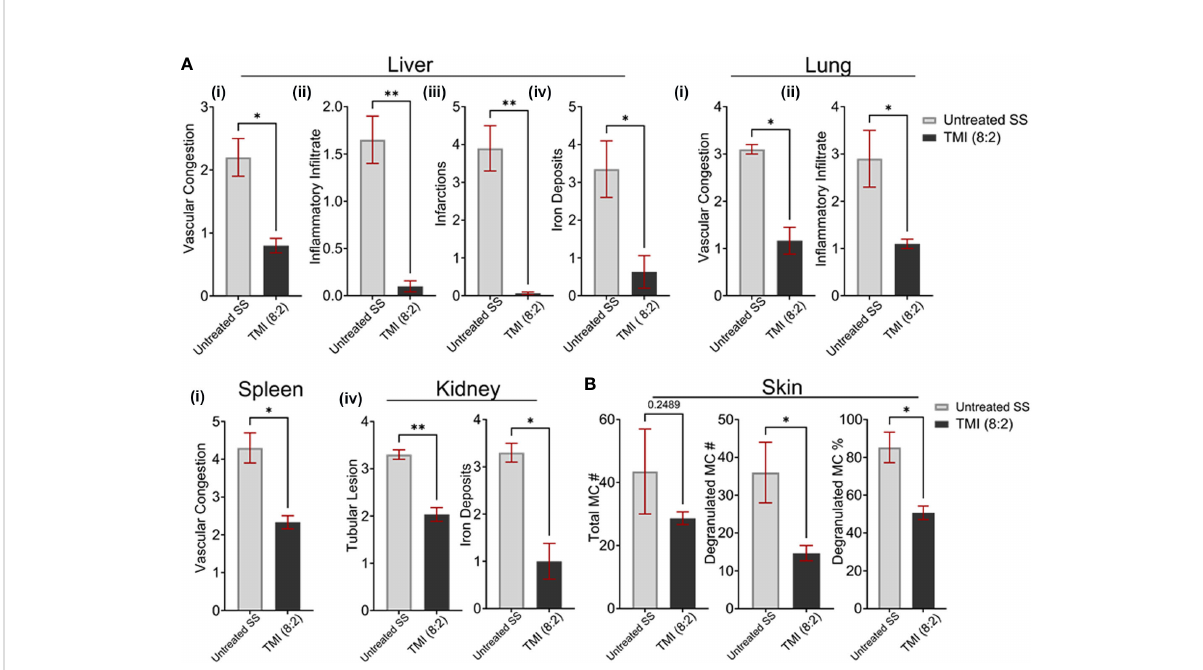
FIGURE 5 TMI (8:2)-treated mice long-term organ morphology assessment. We analyzed H&E- and PAS-stained sections of several organs for vascular congestion, in fl ammatory in fi ltrate infarcts, and iron deposits as described before (1). (A) Compared to untreated SS mice, the TMI (8:2)-treated mice showed signi fi cant reduction in (i) vascular congestion in lungs, liver, and spleen; (ii) in fl ammatory in fi ltrates in liver and lungs; (iii) infarction in liver infarction; and (iv) iron deposits in the liver and kidney. (B) Mast cell number, degranulated mast cell number, and percentage were determined from toluidine blue-stained skin sections from untreated SS mice and TMI (8:2)-treated mice 90 days post-BMT. The TMI-treated mice showed slightly lower but not signi fi cantly different mast cell numbers in the skin; however, the relative number and percentage of degranulated mast cells (activated) were signi fi cantly lower in TMI-treated mice than in untreated SS mice. Data are shown as mean ± SEM, analyzed with unpaired t -test, and two-tailed using GraphPad Prism * p < 0.05, * p < 0.01, ** p <